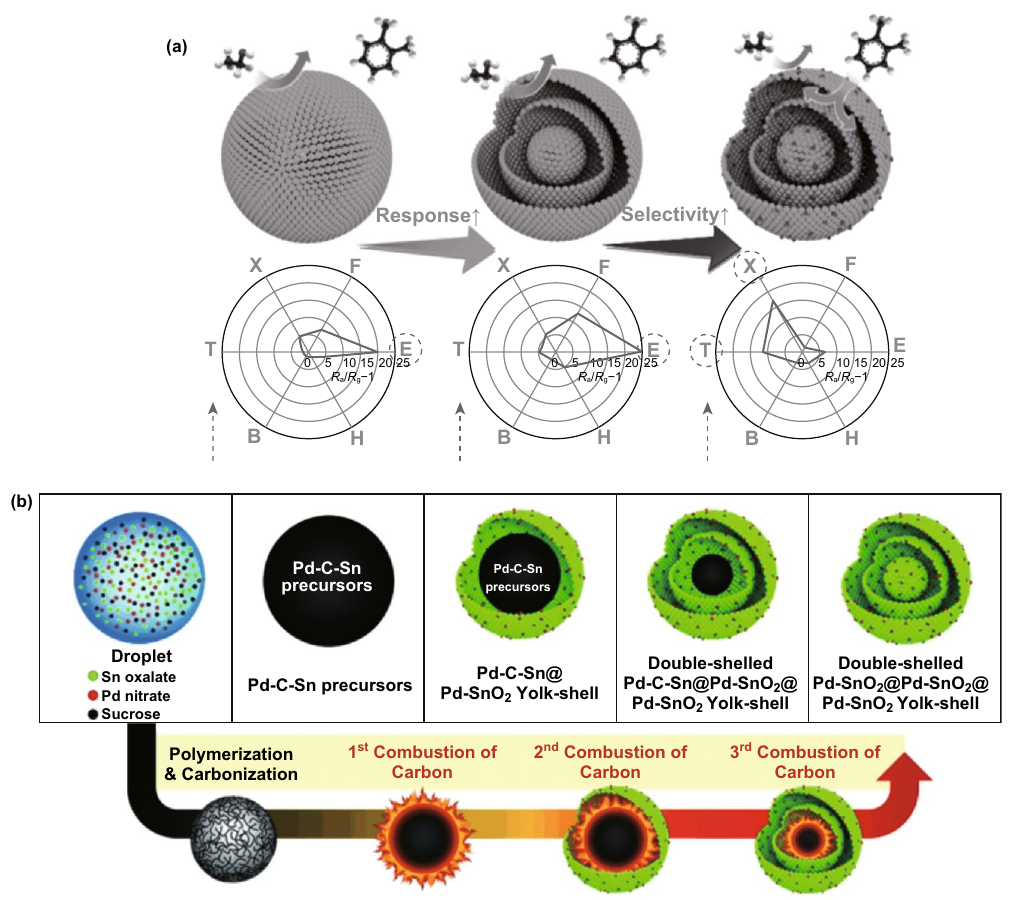
Fig. 5 a Gas responses of dense SnO 2 spheres, SnO 2 yolk–shell spheres, and Pd-loaded SnO 2 yolk–shell spheres to various analytical gases at 350-450 °C (B: benzene, H: H 2 , E: C 2 H 5 OH, F: HCHO, X: o-xylene, T: toluene). b Scheme showing the formation of double-shelled Pd-SnO 2 @ Pd-SnO 2 @Pd-SnO 2 yolk–shell spheres. Reproduced with permission [57]. Copyright 2014, The Royal Society of